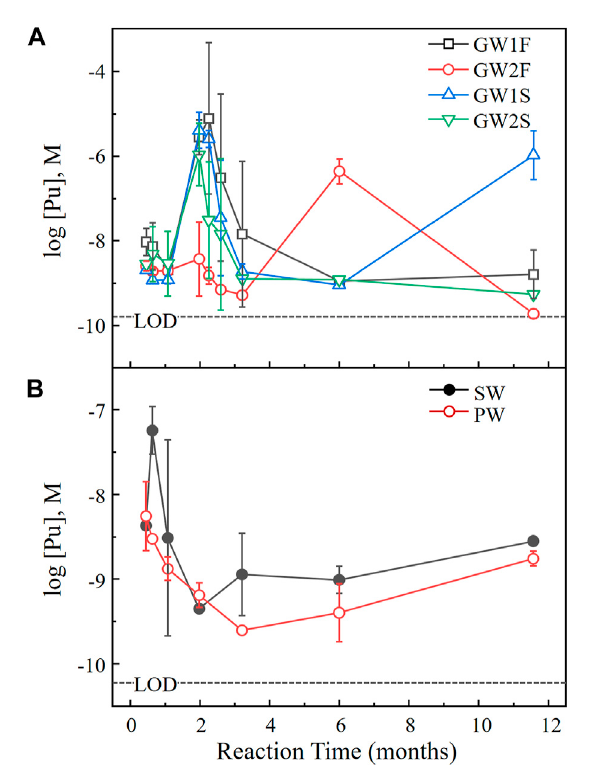
FIGURE 5 Dissolution behaviors of PuO 2 (cr) at 60 ° C in (A) groundwater and (B) seawater and concrete porewater (set A) as a function of the reaction time. The dashed lines indicate the LOD by LSC under the given experimental